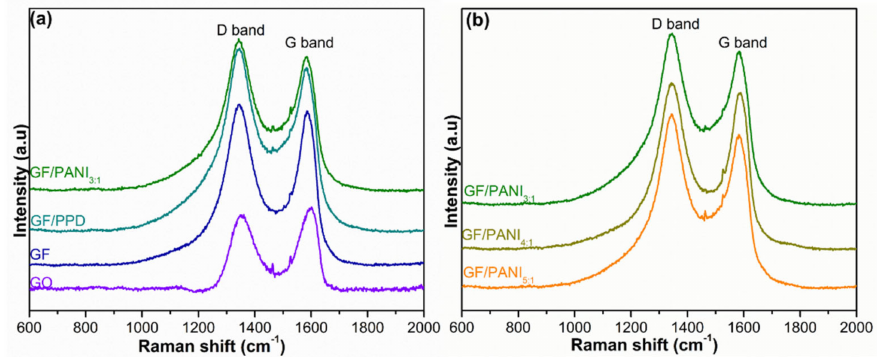
Figure 5. The Raman spectroscopy of ( a ) GO, GF, GF/PPD, GF/PANI 3:1 and ( b ) GF/PANI 5:1 , GF/PANI 4:1 , GF/PANI 3:1 filler with different amount of